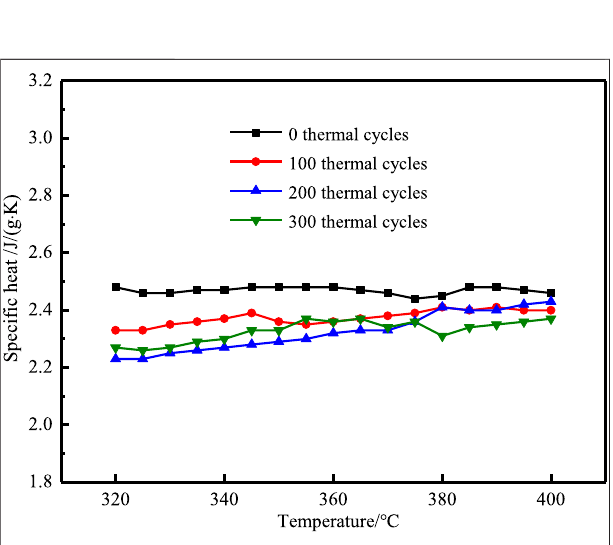
FIGURE 15 | Variation of speci fi c heat after multiple thermal cycles (40 – 265 ° C).